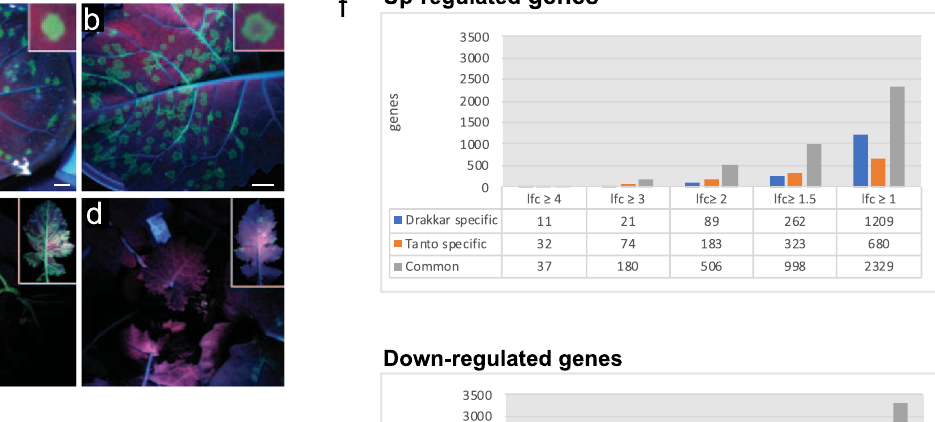
PROTEIN KINASE 36 (CRK36). GH3.12/PBS3 is a positive regulator of plant immunity 45 , ENDO1 degrades single-stranded and double-stranded nucleic acids, PDCB3 contributes to callose deposition at PD 46 , and CRK36 positively regulates immunity through interaction with the cytoplasmic kinase BOTRYTIS- INDUCED KINASE 1, a central regulator of PTI that links the